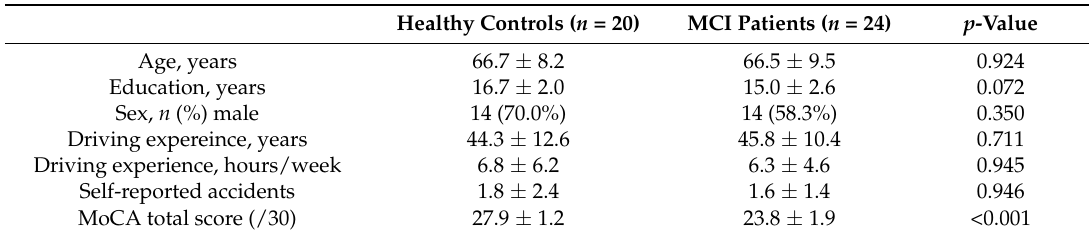
Table 1. Demographic information of patients with MCI ( n = 24) and healthy older control participants ( n = 20) who completed the behavioral (out-of-scanner)